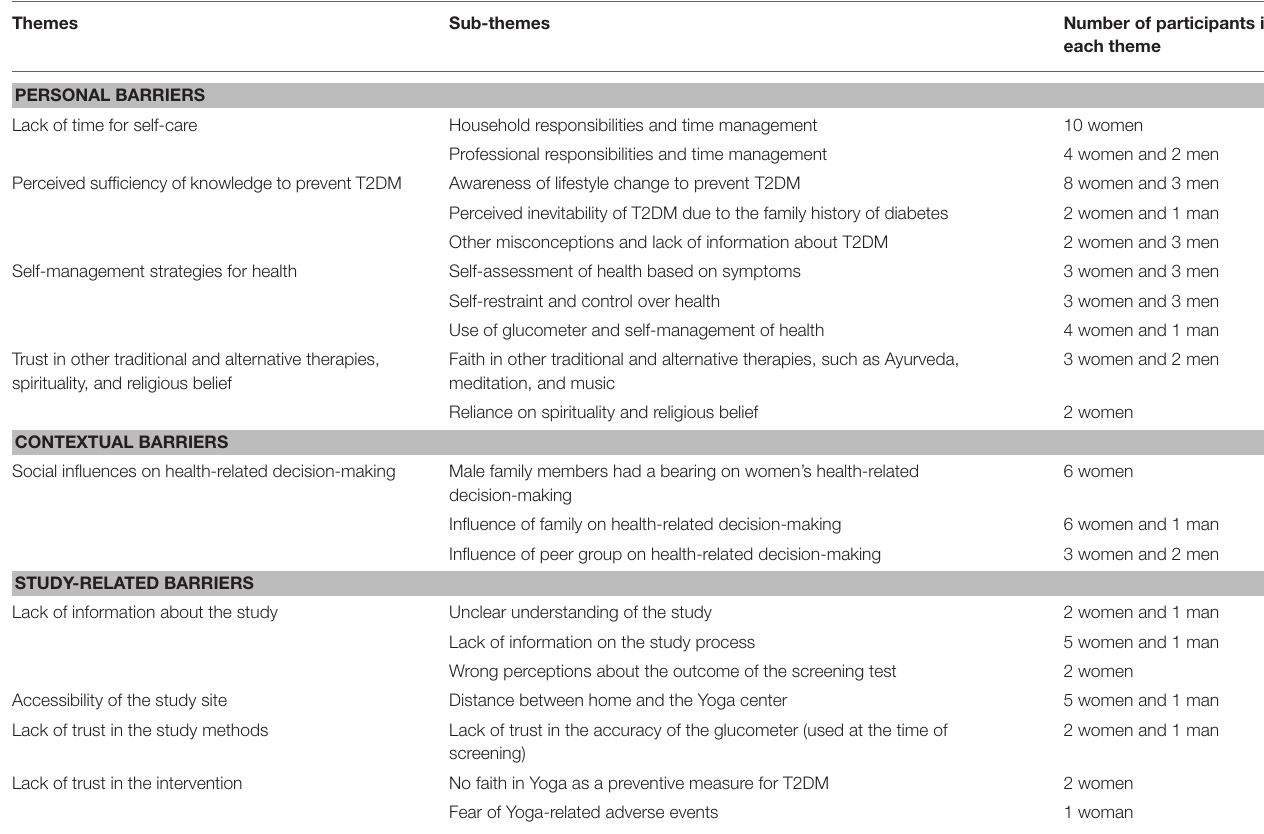
TABLE 2 | Themes and